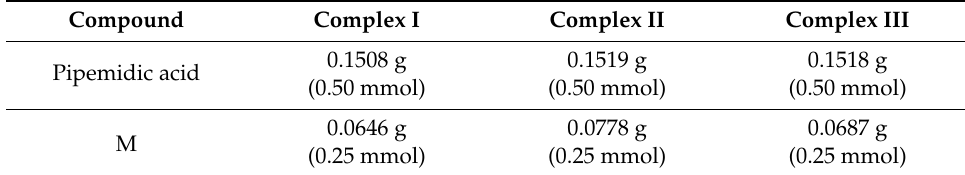
Table 4. Masses weighed for the synthesis of complexes I – III